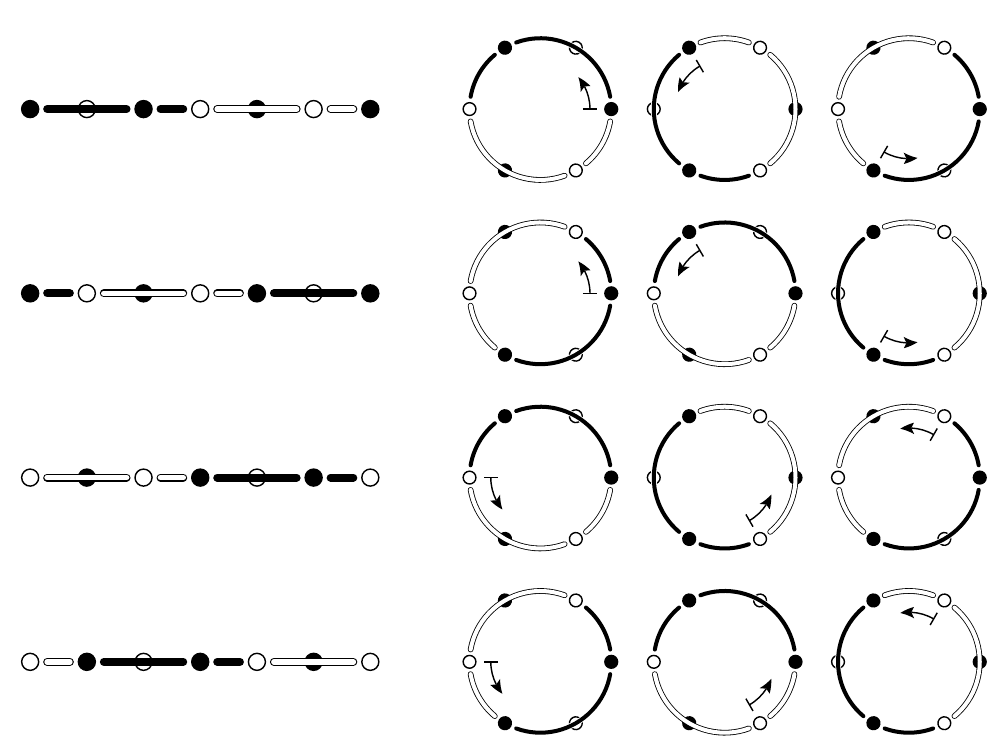
( 1 ) ( 1 ) ( 2 ) ) and diag ( m ( 2 ) m m m 1 2 1 2